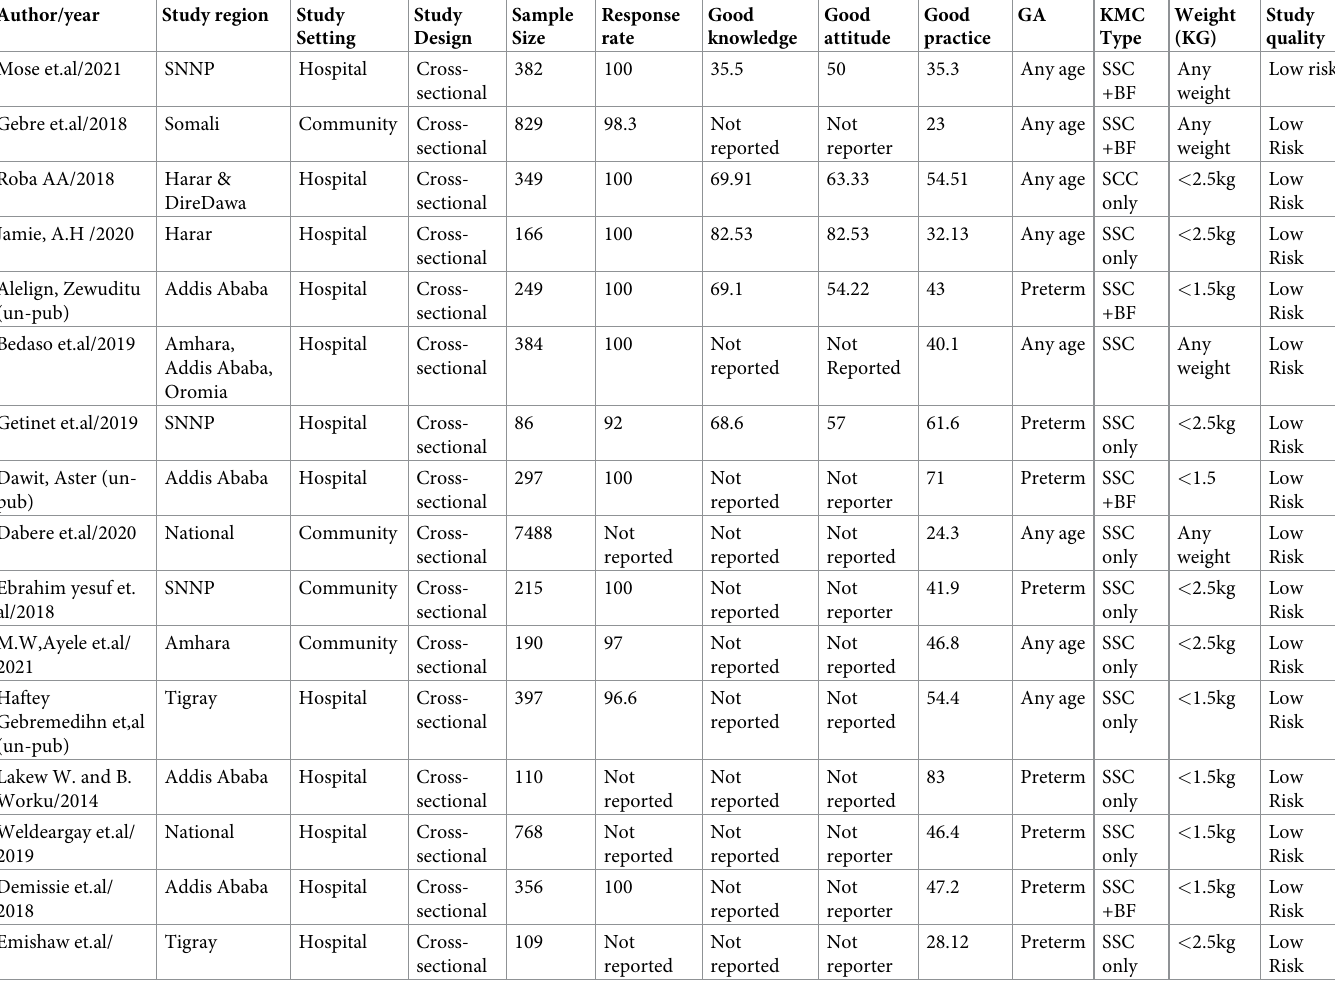
Table 1. Descriptions of the studies used in the systematic review and meta-analysis for the knowledge, attitude, and practice of kangaroo mother care among post- natal women in